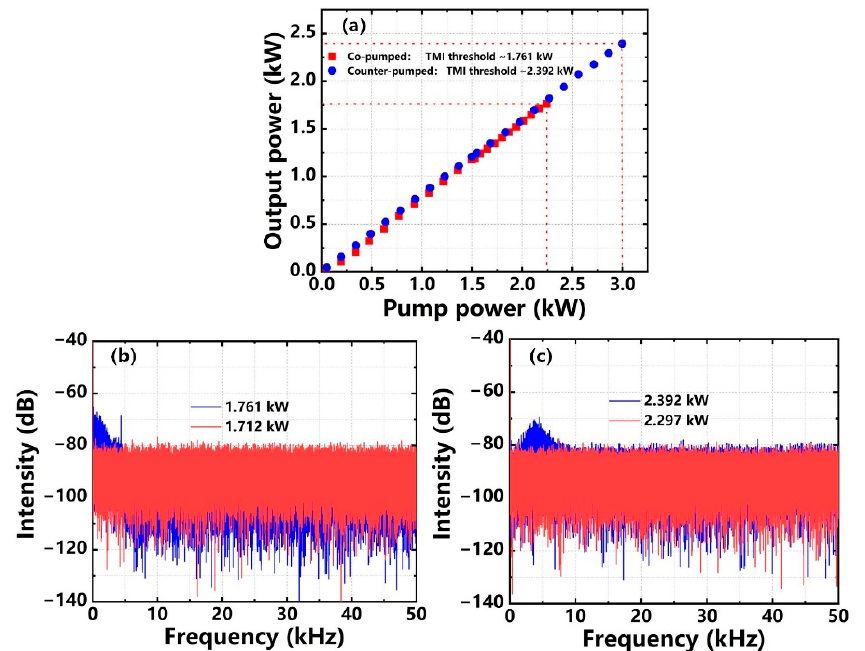
Figure 3. ( a ) Output power curves of unidirectional pumped scheme; ( b ) Co-pumped scheme: PSD at output power of 1.712 kW and 1.761 kW; ( c ) Counter-pumped scheme: PSD at output power of 2.297 kW and 2.392 kW.